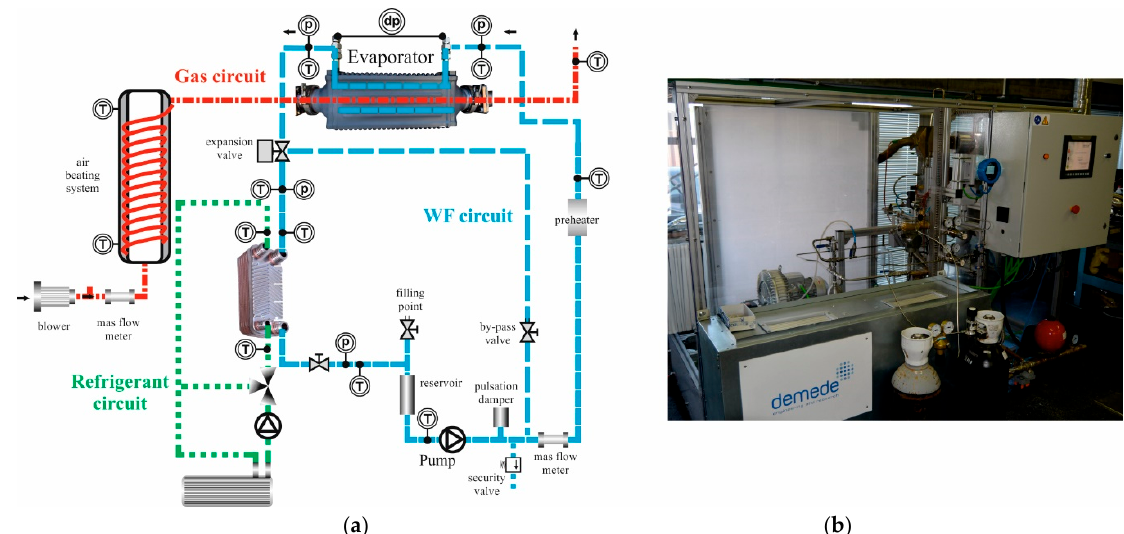
Figure 1. Experimental test bench, schematic diagram ( a ), and photograph ( b ).